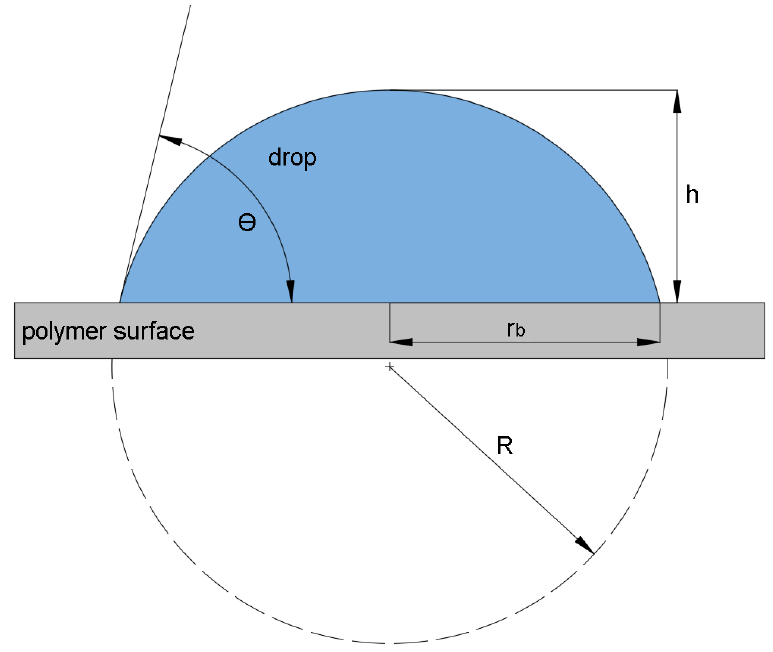
Figure 3. Droplet profile analysis: θ —wetting contact angle, h—droplet height, r b —droplet radius at contact point, and R—entire droplet radius.